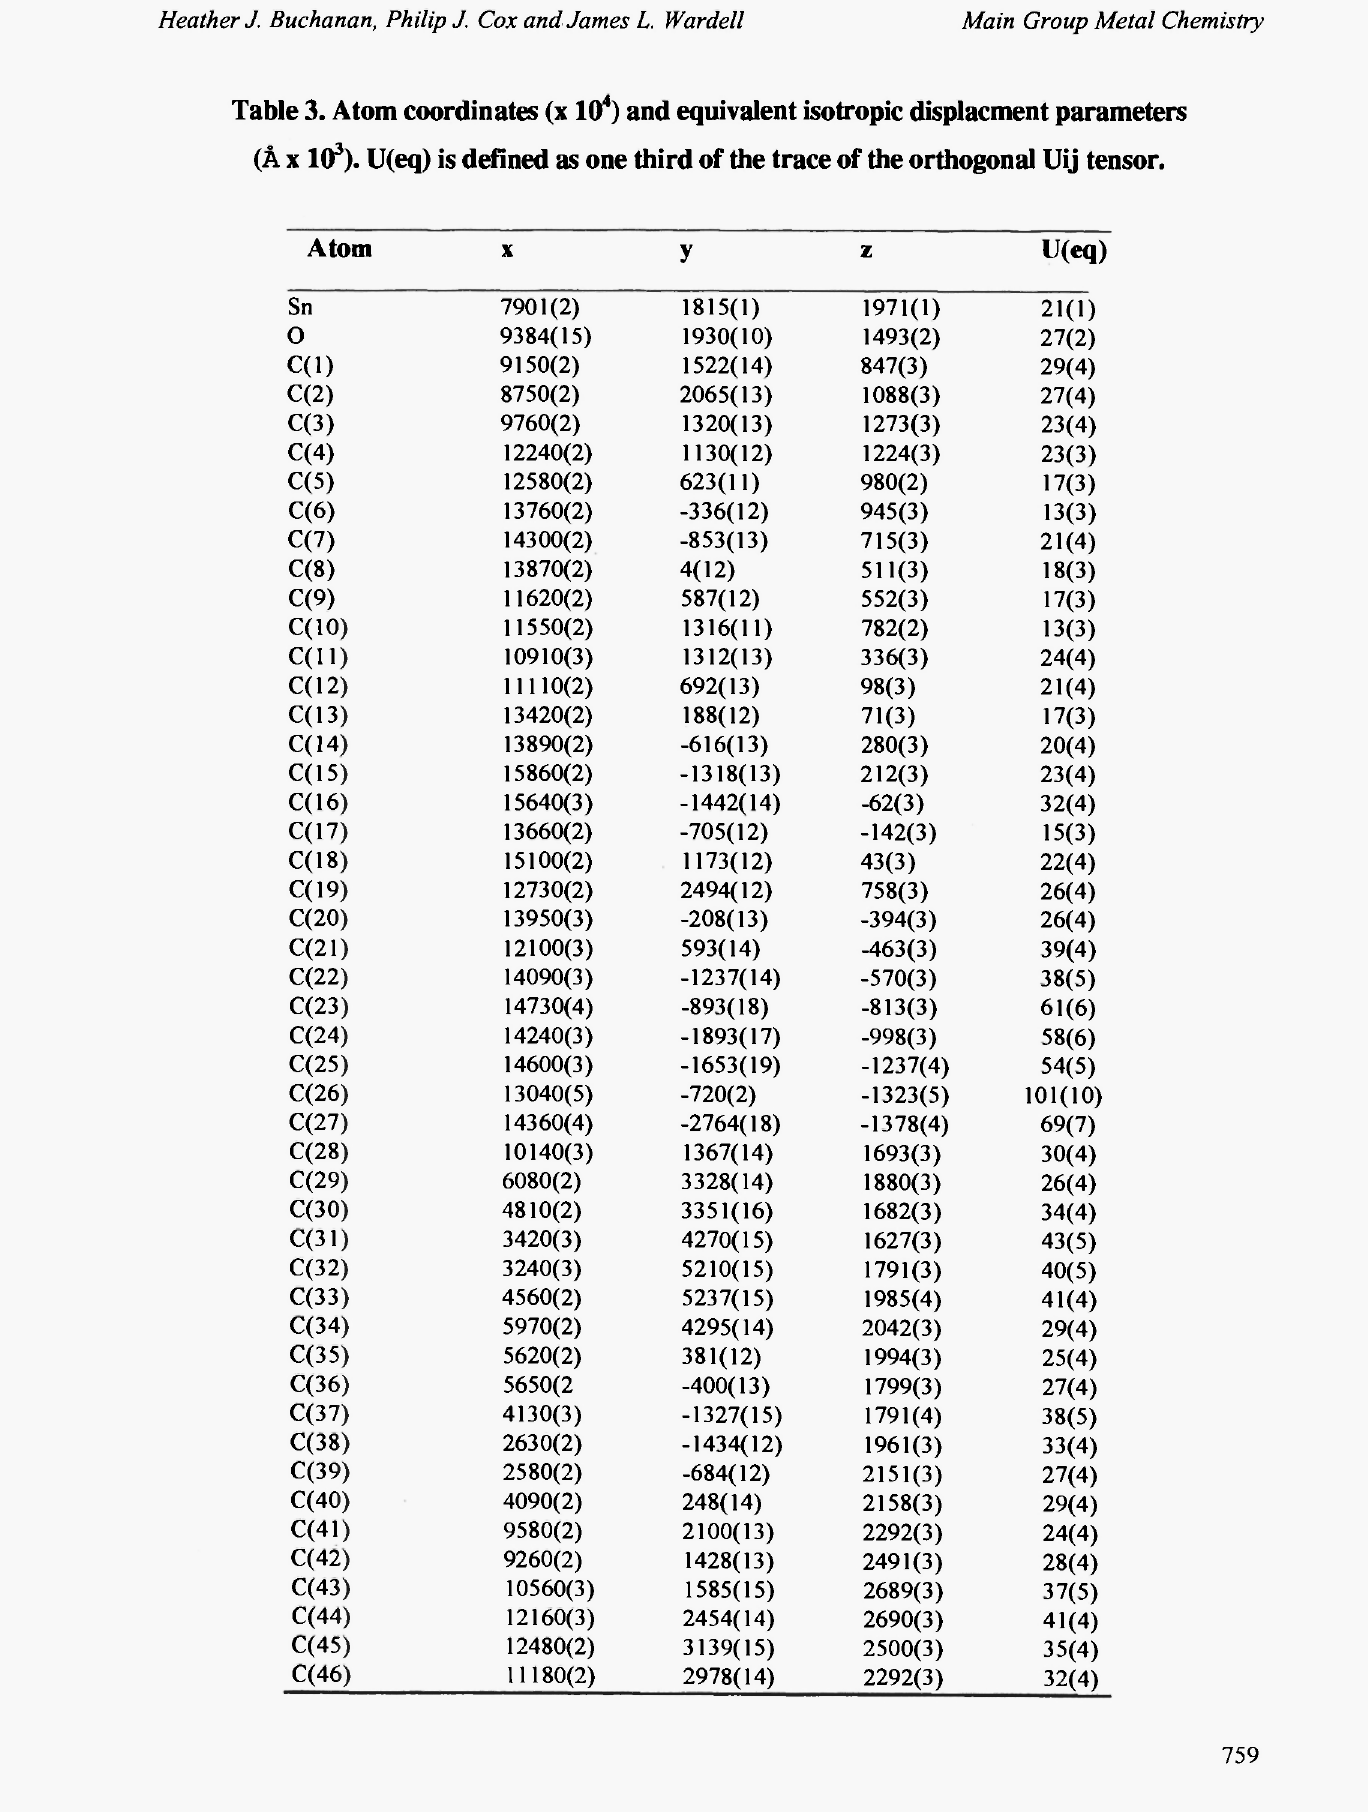
Table 3. Atom coordinates (χ 10 4 ) and equivalent isotropic displacment parameters (Ä χ 10 3 ). U(eq) is defined as one third of the trace of the orthogonal Uij